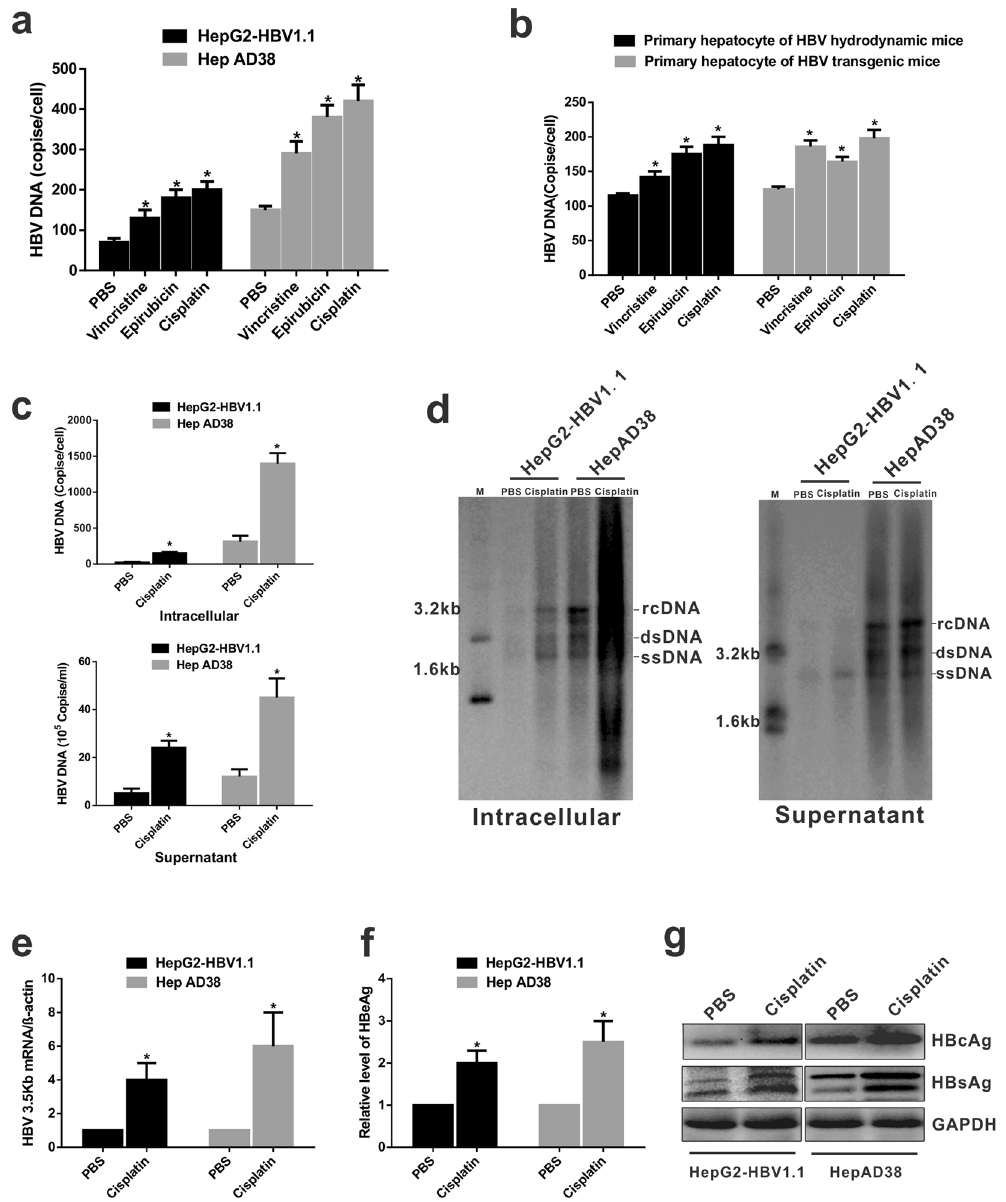
Figure 1. Cisplatin promotes HBV replication in HBV-expressing hepatoma cells. ( a ) Chemotherapy treatment-upregulated HBV replication in stable HBV-expressing cell lines HepAD38 and HepG2-HBV1.1. Cells were treated with 6 μ M cisplatin, 0.3 μ M vincristine, or 0.6 μ M epirubicin for 24 h. Intracellular HBV DNA was extracted and quantified by quantitative PCR analysis. Values were normalized to PBS control. The data represent the mean value from independent experiments (n = 3). * p < 0.05 vs. PBS control. ( b ) Primary hepatocytes were isolated from HBV transgenic mice (HBV-Tg mice) or HBV hydrodynamic mice. Cells were treated with the indicated concentration of the chemotherapy drug. Intracellular HBV DNA was quantified as described in a . ( c ) HepAD38 and HepG2-HBV1.1 cells were treated with 6 μ M cisplatin. Cell lysates and culture supernatants were harvested at day 4 after treatment. Intracellular (top panel) and supernatant (bottom panel) HBV DNA levels were quantified by real-time PCR assay. Data represent the means ± SD (independent experiments, n = 3); * p < 0.05 vs. PBS control. ( d ) Intracellular or secreted HBV DNA was determined by Southern blot analysis. rc DNA, relaxed circular DNA; ds DNA, double-stranded DNA; ss DNA, single-stranded DNA. ( e , f ) Quantification of HBV 3.5 kb mRNA levels ( e ) or secreted HBeAg (f) in HepAD38 and HepG2- HBV1.1 cells. Data represent the mean value from independent experiments (n = 3). * p < 0.05 vs. PBS control. ( g ) Intracellular HBcAg and HBsAg were measured by western blotting. GAPDH was used as loading control. The cropped blots are used in the figure and full length blots are presented in Supplementary Fig.